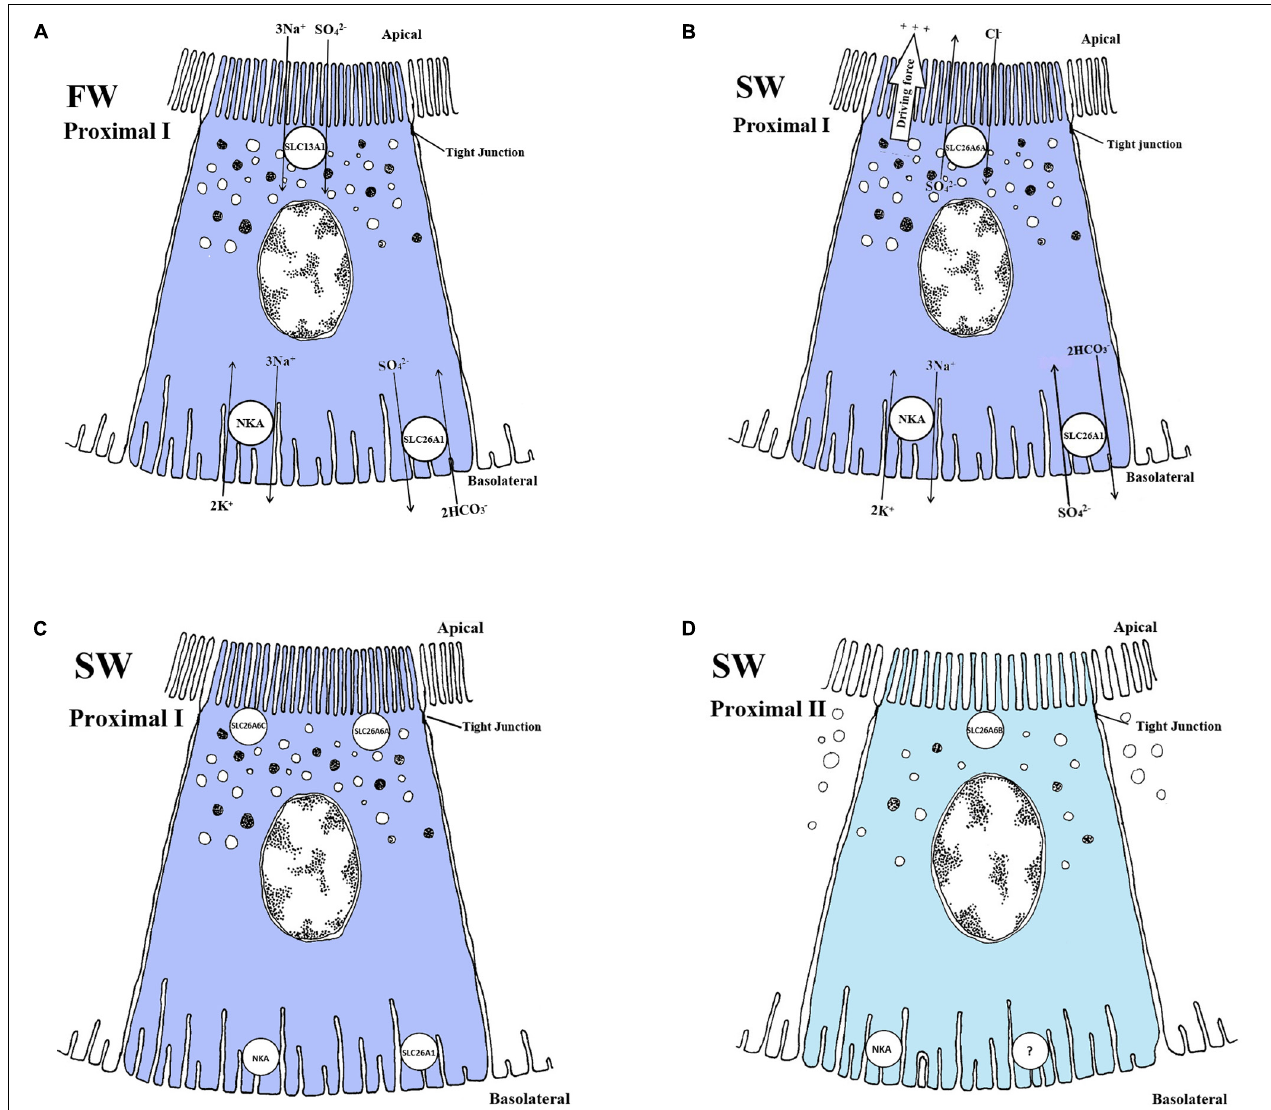
FIGURE 5 | Schematic overview showing localization and mechanism of SO 42 − transport in FW (A) and SW (B, C and D) teleosts. (A) SLC13A1 is located on apical membranes, co-transporting 3Na + /SO 42 − , while SLC26A1 is an electroneutral SO 42 − /HCO 3 − exchanger located on basolateral membranes, driven by Na + , K + -ATPase (NKA) creating a transmembrane Na + gradient. This transport is located in proximal tubule cells. (B) SLC26A6A is an electrogenic SO 42 − /Cl − exchanger located apically, while the SLC26A1 are able to switch the exchange ratio in SW so that it exchanges SO 42 − /HCO 3 − in the opposite direction of FW. NKA creates an electronegative potential in the cell, favoring the transport in SW. (C and D) (only showing location) The apical SLC26A6C, SLC26A6A and the basolateral SLC26A1 are located in proximal tubule I (PI), while SLC26A6B are found apical in the proximal tubule II (PII), respectively. The exchange ratios for SLC26A6B and SLC26A6C are not known. Models based on Nakada et al. (2005) (FW), Kato et al. (2009) (SW) and Watanabe and Takei (2011b)